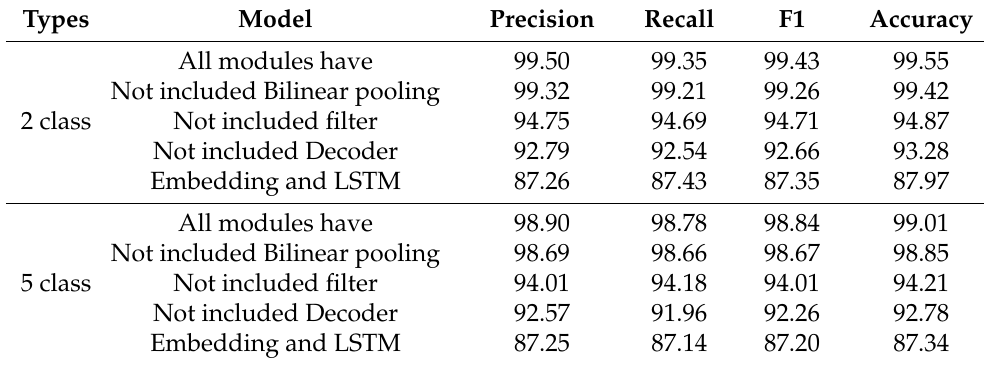
Table 4. Model ablation